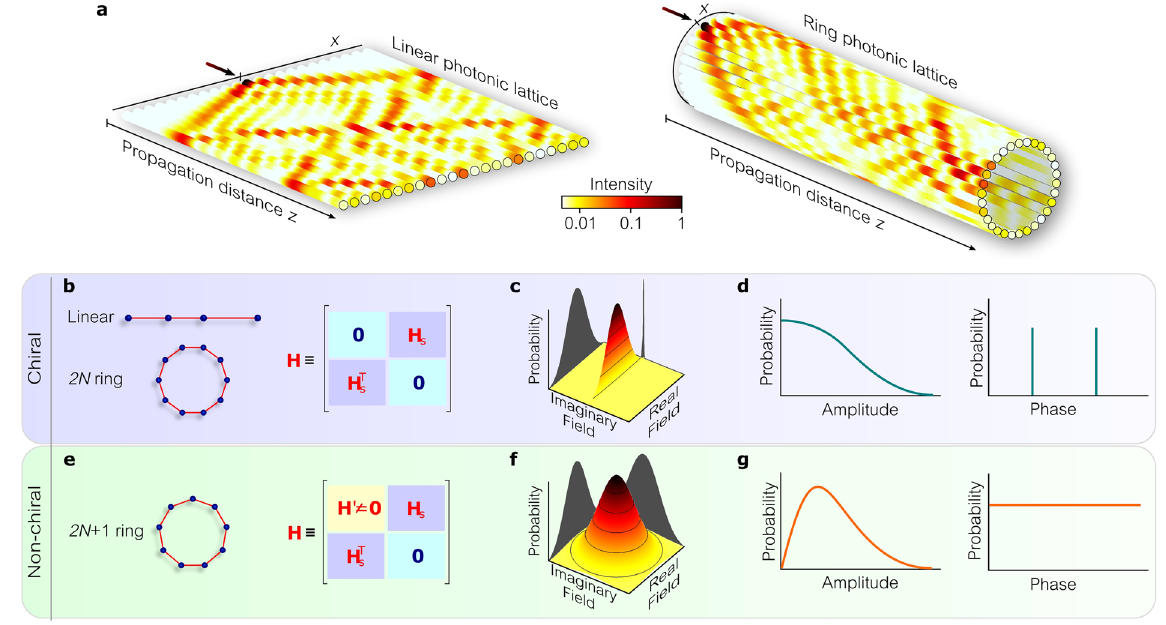
Figure 1. Propagation of light along disordered coupled waveguides arranged on different 1D lattice topologies. ( a ) Evolution of the intensity along single realizations of 1D disordered linear and ring photonic lattices. The black arrow indicates the single waveguide excited at the input. ( b ) The coupling matrix associated with linear or even-sited ring lattices with off-diagonal disorder can be rearranged into block off-diagonal form. ( c ) Probability density function of the complex field produced by the lattices in ( b ). The field has only one quadrature component, either real or imaginary. ( d ) The probability distribution of the amplitude is half bell-shaped and the phase distribution is discrete. ( e – g ) Similar to ( b – d ) for odd-sited ring lattices. ( e) The coupling matrix cannot be rearranged into block off-diagonal form, ( f ) the probability distribution of the field is circularly symmetric in the complex plane resulting in ( g ) a Rayleigh-like amplitude distribution and a uniform phase